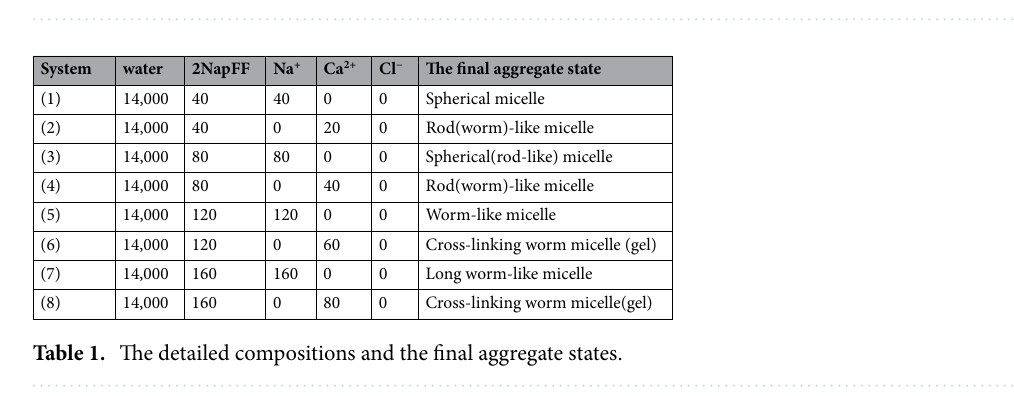
Figure 2. The stages of aggregate formation in the systems. Marks (a-h) correspond to systems (1–8) in Table 1. Water and ions are removed from the images.